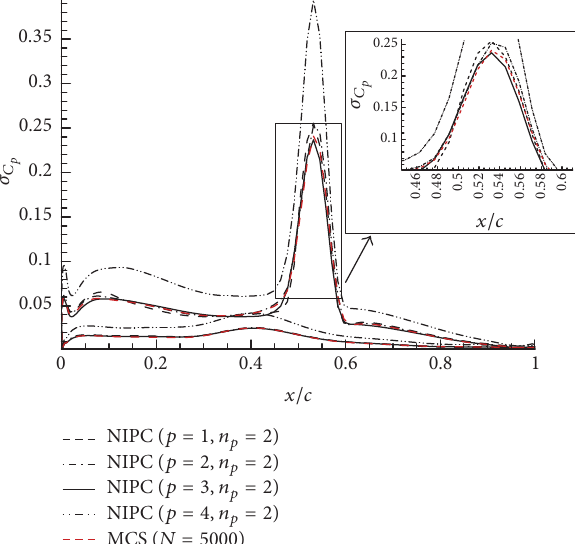
Figure 5: Standard deviation distribution of 𝐶 𝑝 with the order of NIPC.